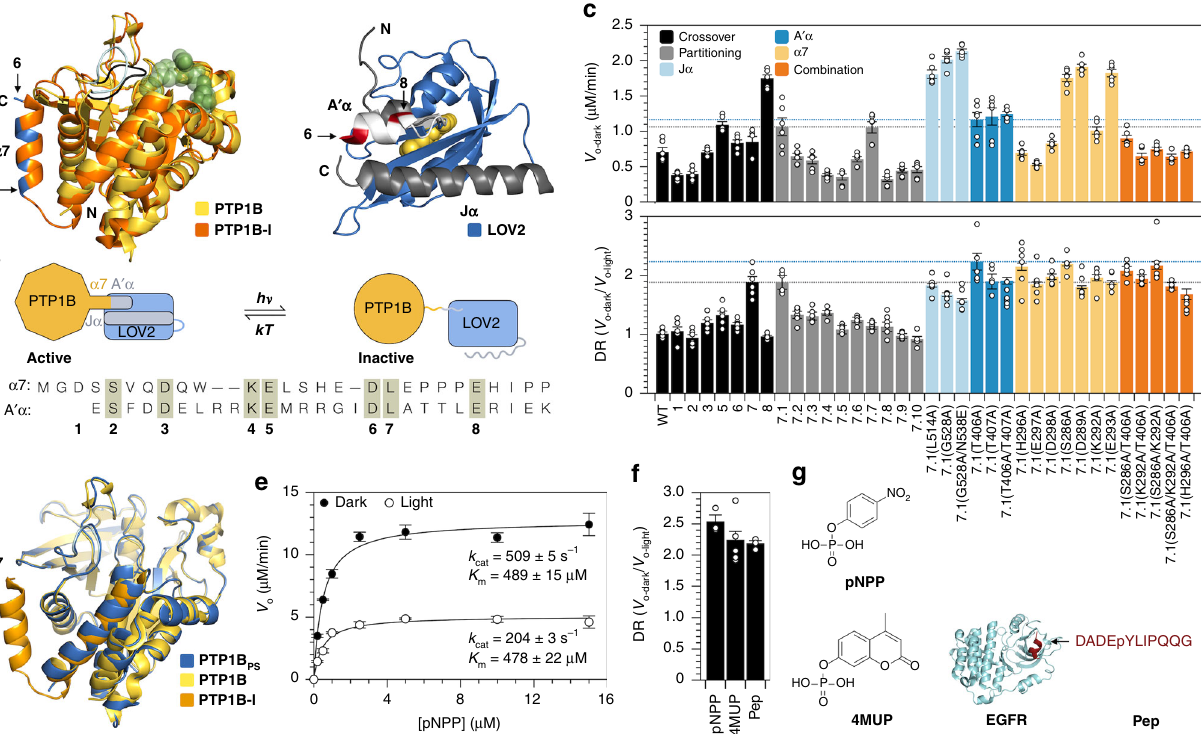
Fig. 1 Minimally disruptive photocontrol of PTP1B. a Left: An alignment of a competitively inhibited structure of PTP1B (orange, pdb entry 2f71) and an apo structure of PTP1B (yellow, pdb entry 3a5j) highlights an allosteric control system. Closure of the WPD loop (black) over an inhibitor orders the α 7 helix; opening of the loop (light blue) hinders this ordering. Right: An alignment of the LOV2 domain from A. sativa (blue) and an N-terminal segment of the same domain of A. thaliana (white) that is identical between the two proteins (pdb entries 2v0w and 4hhd, respectively). Two terminal α -helices (gray and white) are stable in the dark state, but not the light state. b Design of a photoswitchable chimera. Light-induced unwinding of the A ’ α helix of LOV2 destabilizes the α 7 helix of PTP1B, causing an allosteric conformational change that inhibits catalysis. We attached the C-terminal α 7 helix of PTP1B to the N-terminal A ’ α helix of LOV2 at crossover points in a primary sequence alignment (1 – 8). These points are highlighted in blue (PTP1B) and red (LOV2) in ( a ). c Assays on 4-methylumbelliferyl phosphate (4MUP) show the results of chimera optimization. Construct 7 has the largest dynamic range (DR) of the crossover variants; 7.1 has a higher activity than 7, and 7.1(T406A), termed PTP1B PS , has a larger DR than 7.1. The dashed gray and blue lines denote values for 7.1 and 7.1(T406A), respectively. The plotted data depict the mean, SE, and associated estimates of DR for n = 6 independent experiments. d Aligned catalytic domains of PTP1B in three structures: photoswitchable (6ntp), apo (3a5j), and competitively inhibited (2f71, α 6 and α 7 only). e An analysis of the activity of PTP1B PS on p-nitrophenyl-phosphate (pNPP) indicates that light affects k cat , but not K m ( k cat-dark / k cat-ligh t = 2.50 ± 0.04). Error bars denote SE for n = 3 independent reactions. f The DR of PTP1B PS is similar for substrates of different sizes. The plotted data depict the mean, SE, and associated estimates of DR for n ≥ 3 independent reactions. g Structures of pNPP, 4MUP, and a peptide (PEP) derived from epidermal growth factor receptor (EGFR). Source data are provided as a Source Data fi